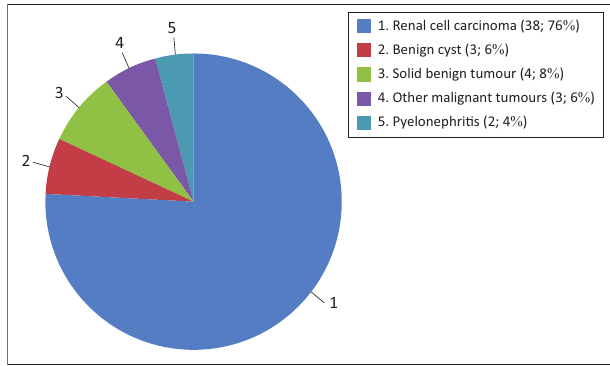
FIGURE 1: Distribution of histopathological findings: Histology final diagnosis ( n ; % )